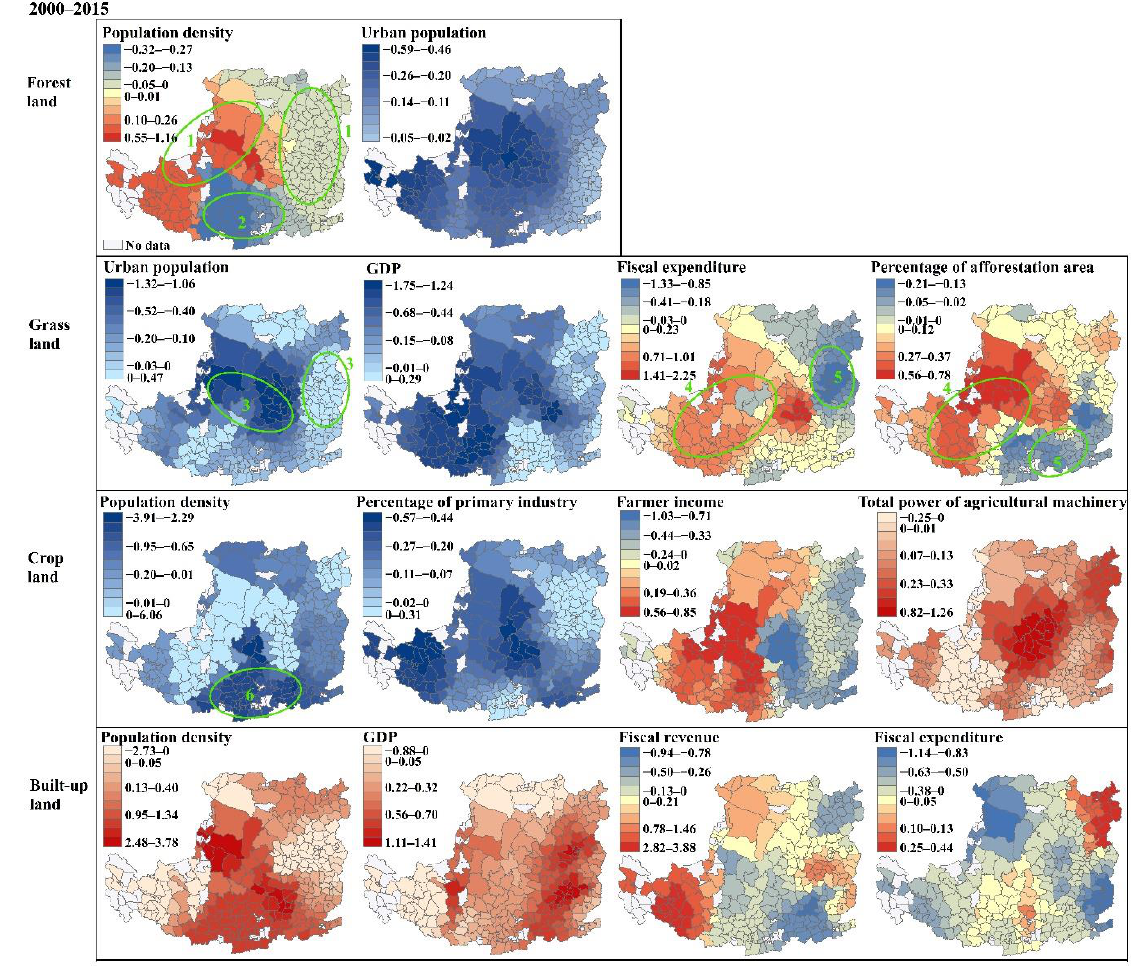
ffi cient estimates for changes of four land-use types from 2000 to Figure 10. GW regression coefficient estimates for changes of four land-use types from 2000 to 2015. Figure 10. GW regression coe